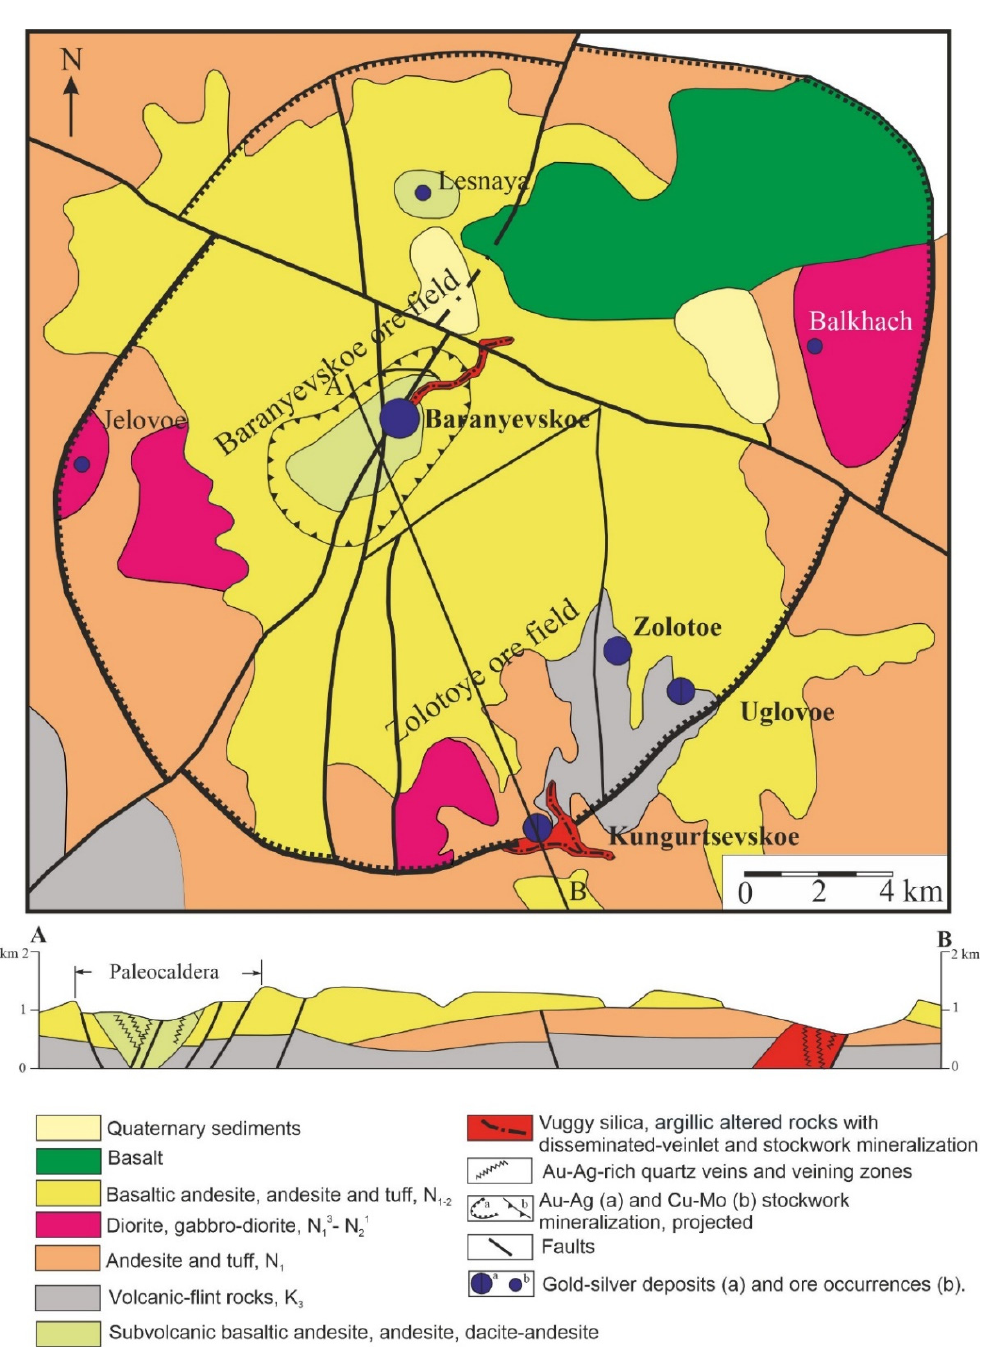
Figure 2. Geological-structural diagram of the Balkhach volcano-tectonic structure and respective A-B cross-section modified after [18,26].